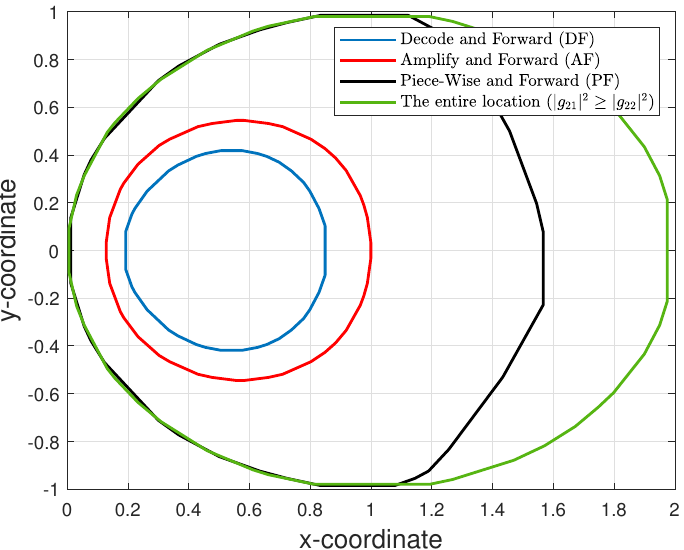
Figure 8. A comparison of the locations that PF-NOMA, DF-NOMA and AF-NOMA can cover for the rate greater than or equal to 0.5 bit/s/Hz at the second receiver